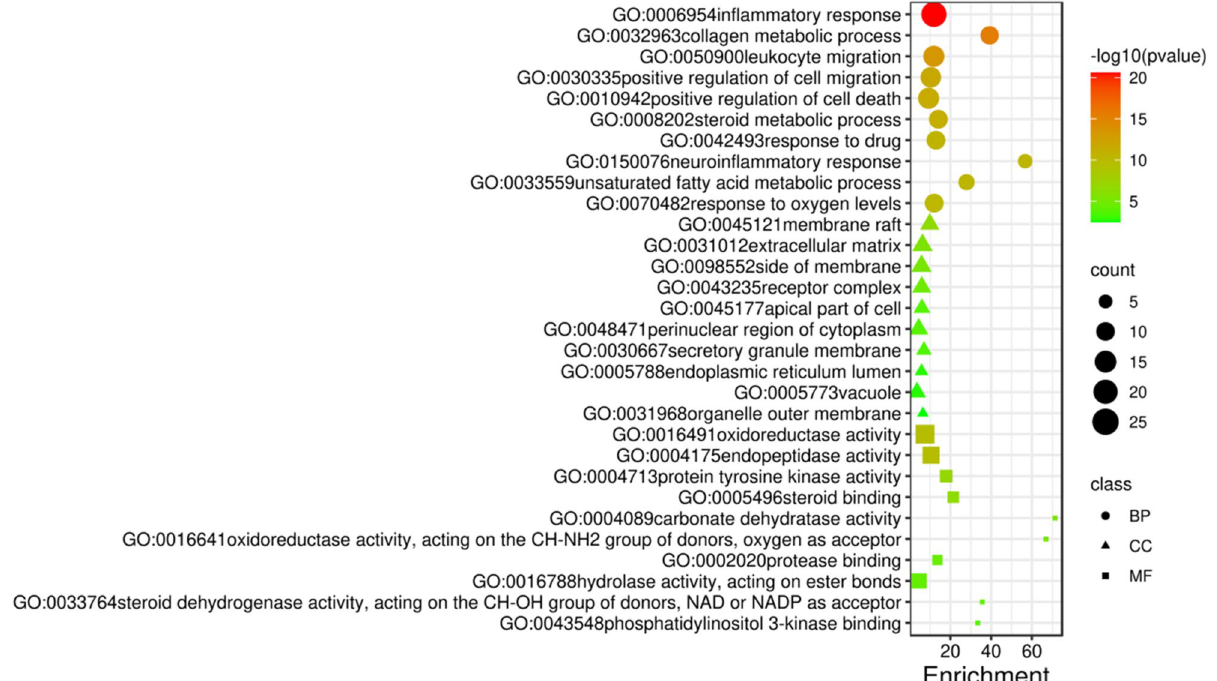
Figure 6. GO enrichment analysis of overlapping targets, including biological processes, cellular components, and molecular functions. The color represents the different − Log10 ( P value), the size of the circle represents the